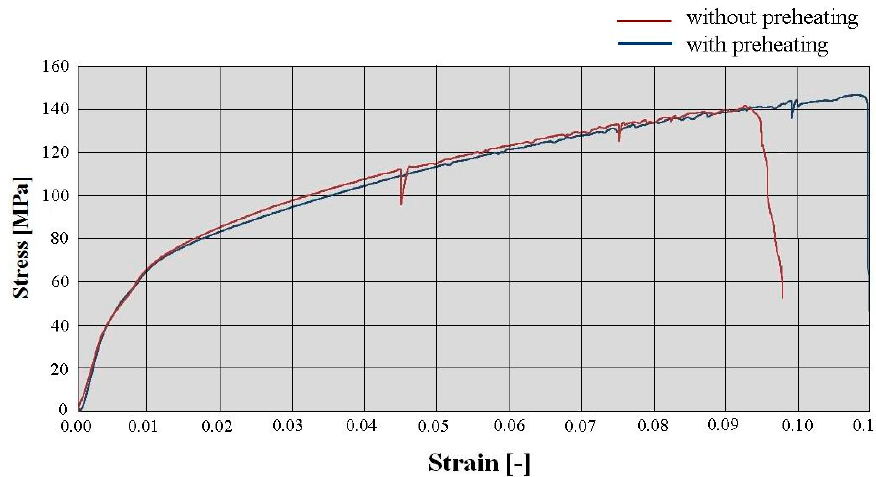
Figure 7. Diagram of the static tension test performed on the welded material EN AW 6063.T66 without preheating (red curve) and with preheating (blue curve) in the alpha-geometry of the weld surface.